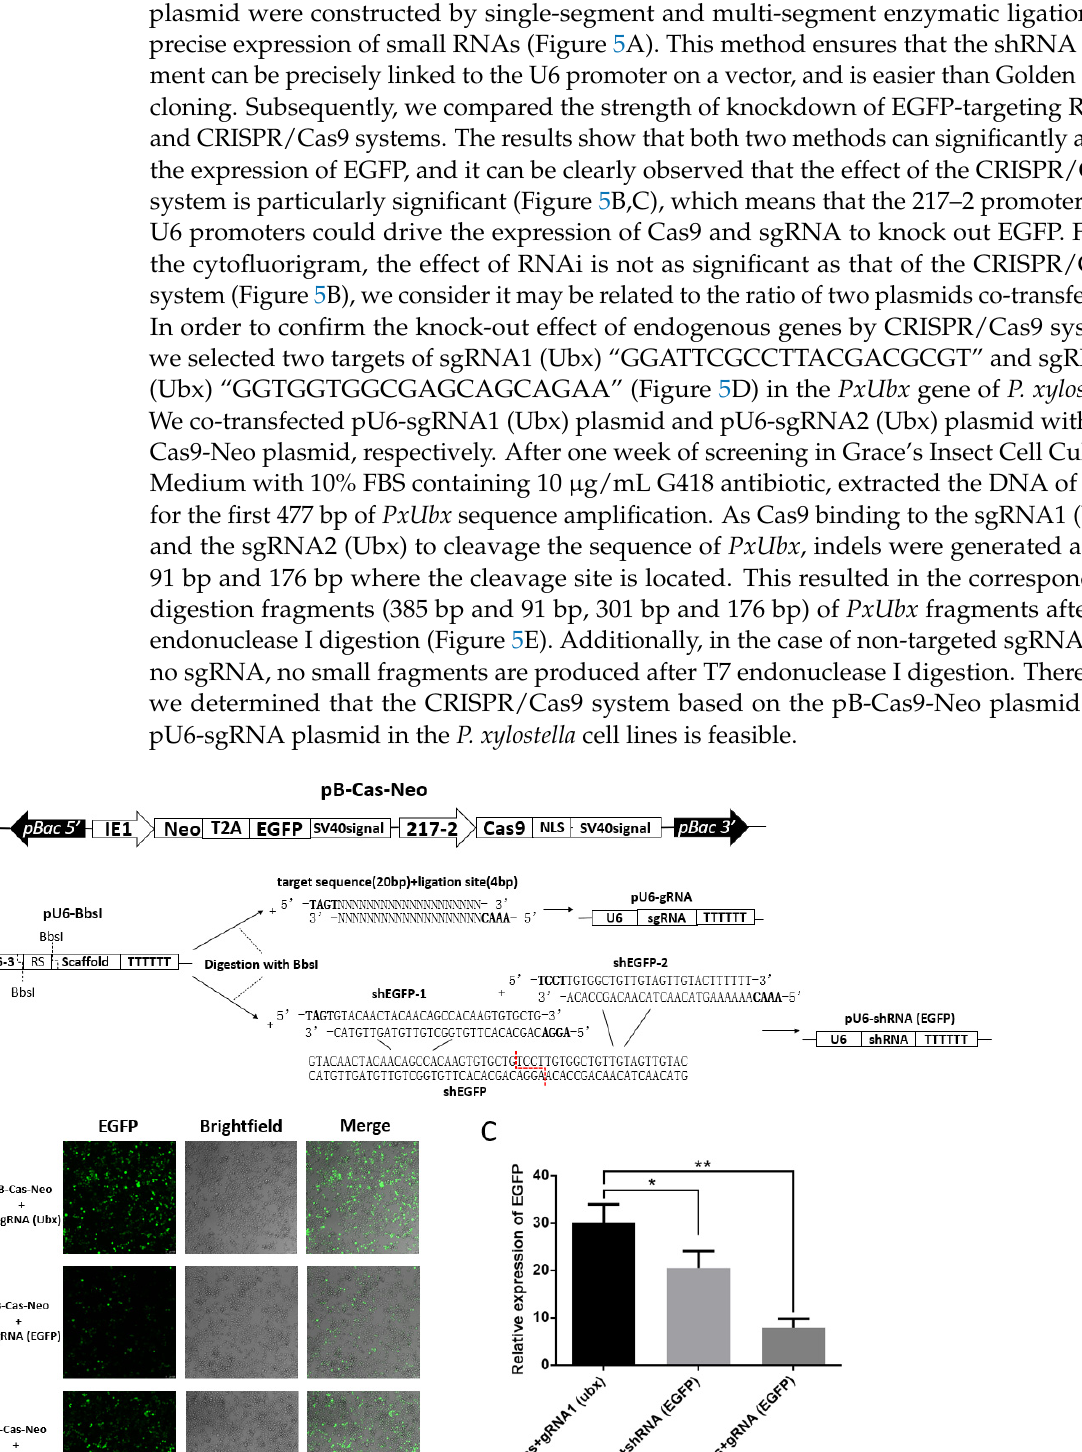
Figure 5. CRISPR/Cas9 system knocks out exogenous and endogenous genes in the P. xylostella cell lines. ( A ) Plasmids for RNAi and CRISPR/Cas9 system. ( B ) Fluorescence images of CRISPR/Cas9